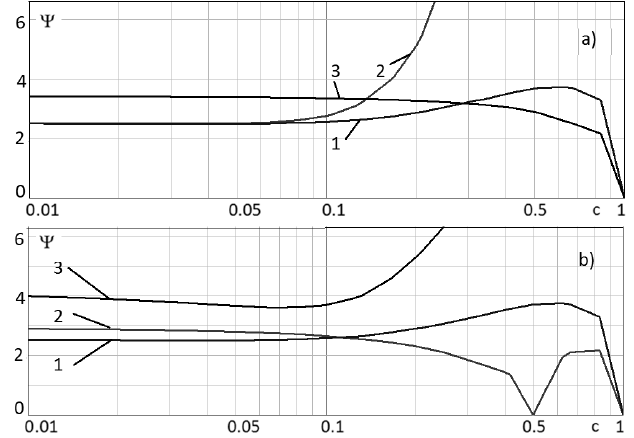
Figure 5. The error functions Ψ of the numerical solution of the test problem I depending on the values of the Courant numbers: ( a ): 1—scheme (14), 2—scheme (18), 3—scheme (19); ( b ): 1—scheme (14), 2—Upwind Leapfrog scheme with TVD-limiters, 3—Standard Leapfrog scheme with TVD-limiters.